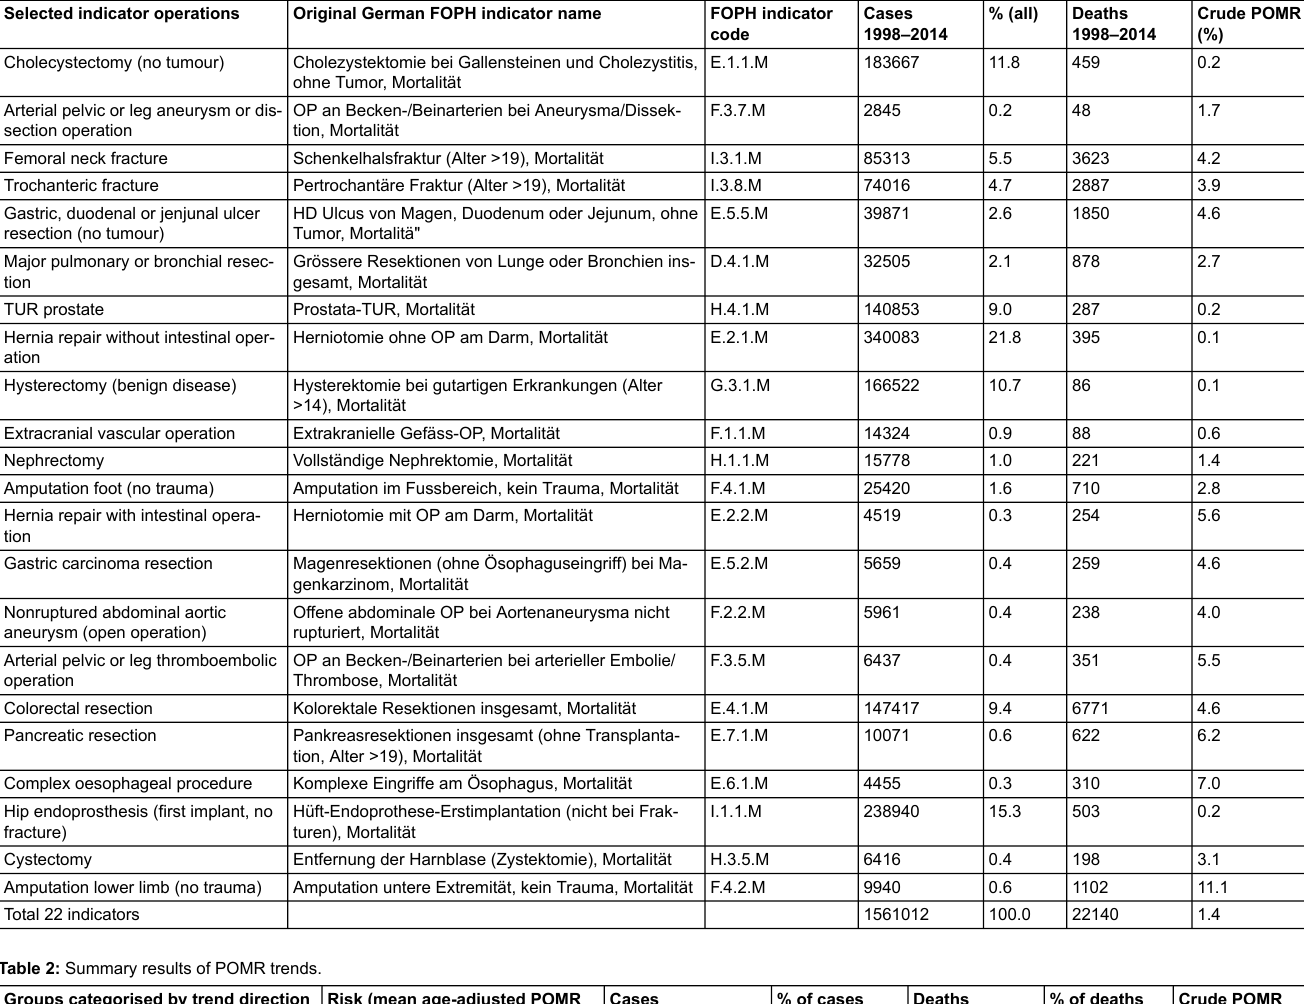
Table 1: Indicator operations (IOR) used by the Federal Office of Public Health (FOPH) and selected for time trend analysis. Selected indicator operations